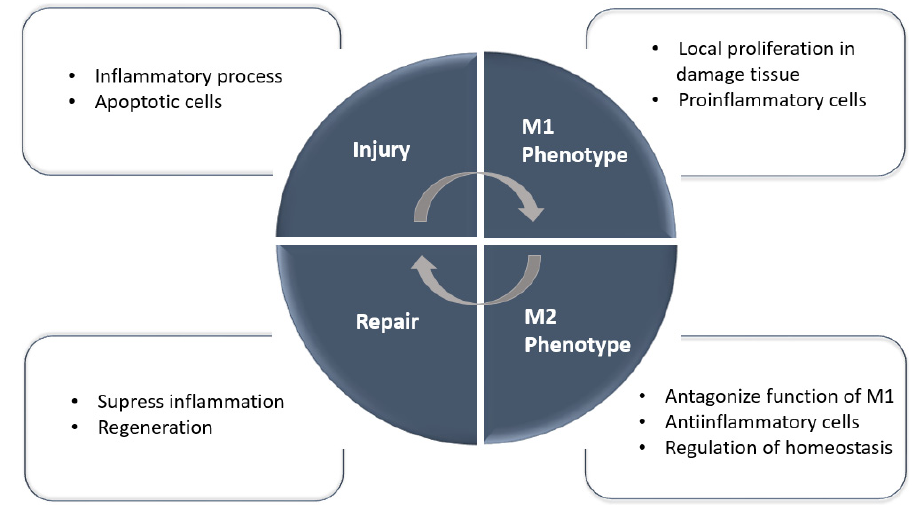
Figure 2. Macrophages in homeostasis, injury, and repair. During the repair phase, M2 macrophages predominate and may originate from in situ proliferation, differentiation from infiltrating monocytes, or phenotype changes from M1 macrophages. M1 macrophages specifically predominate during the injury and inflammation phase.